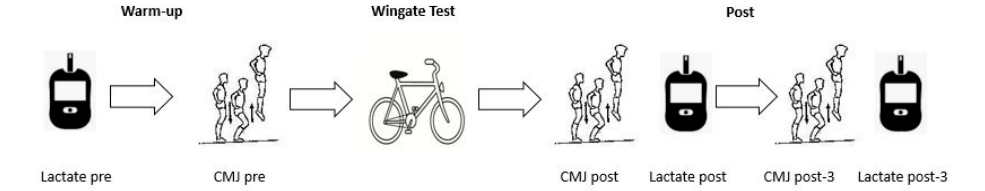
Figure 1. Experimental procedure.